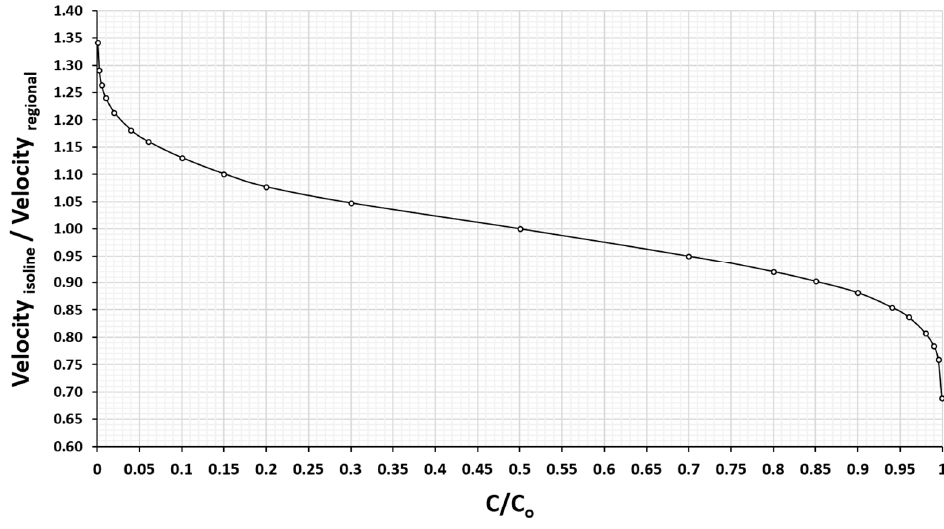
(cid:2932) (cid:3161)(cid:4594) = Ψ ( c (cid:48) ) (only advective =  (c (cid:4593) ) (only advective effect). Figure 7. Universal dependence v c (cid:48) v o (cid:2932) (cid:3173)